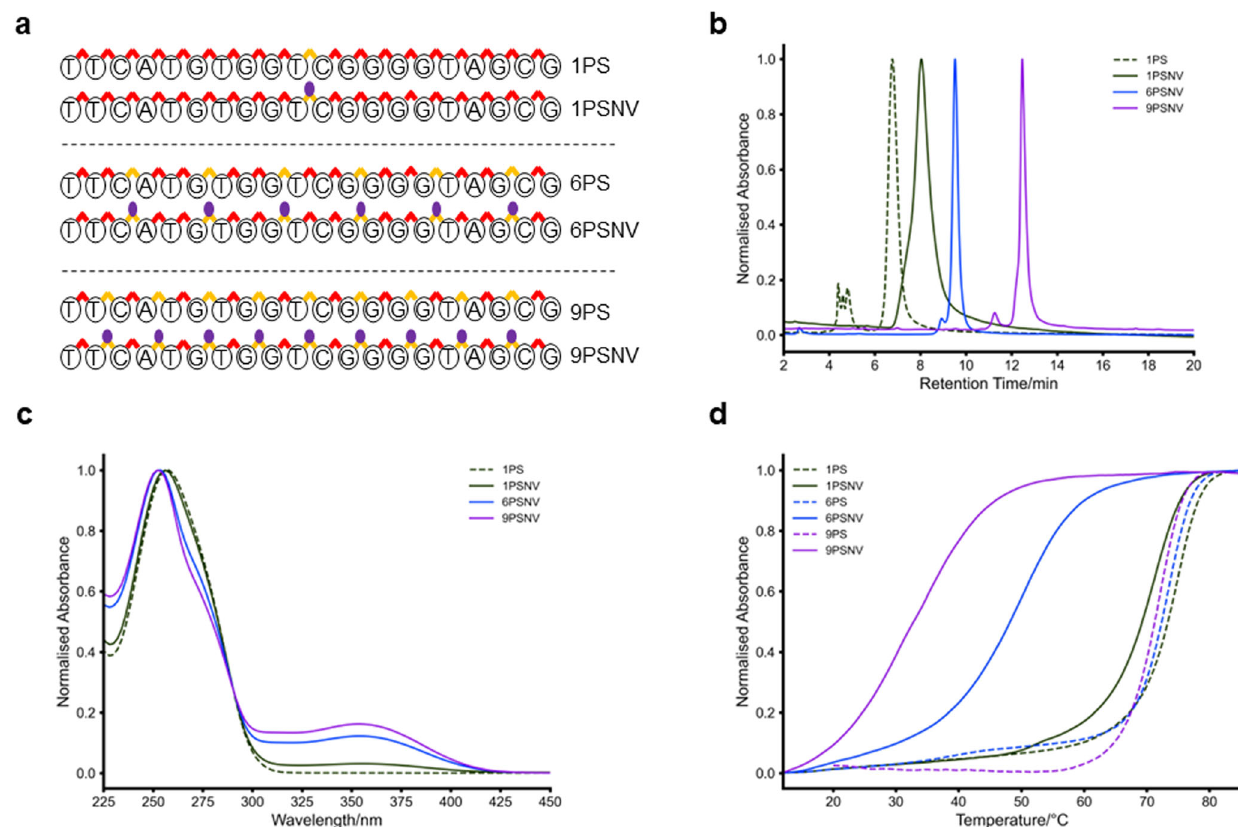
Fig. 3 Synthesis and characterisation of NV-modi fi ed oligonucleotides containing different numbers of PS linkages. a Modi fi ed PSNV oligonucleotides showing the pattern of 1 or 2 PO linkages between PSNV linkages, along with a singly PS-modi fi ed oligonucleotide. b HPLC-chromatogram of all the NV- modi fi ed oligonucleotides, compared to the 1PS oligonucleotide. A drastic increase in hydrophobicity was observed with increasing degree of NV- modi fi cation. c UV-visible absorbance spectra of the NV-modi fi ed oligonucleotides as recorded by HPLC. An increase in the absorbance at ~360 nm, corresponding to the NV-group is observed, as well as a slight hypsochromic shift of λ max at ~260 nm. d Representative melting temperature (T m ) curves recorded for the PS- and PSNV-oligonucleotides. A small decrease in T m was observed with introduction of more PS-linkages, and a drastic decrease in T m was observed upon modi fi cation of PS-linkages with